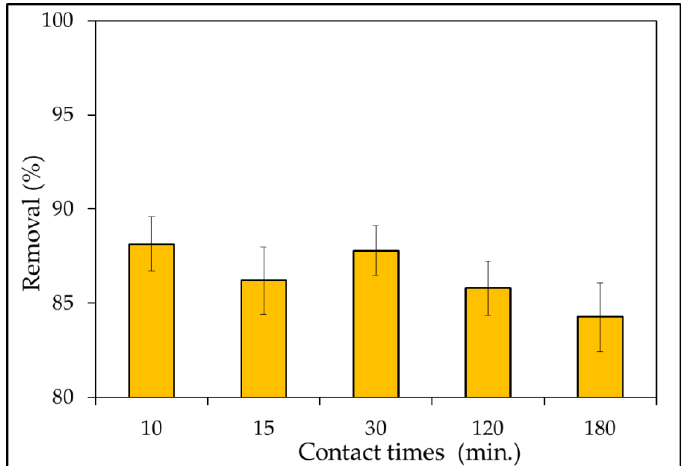
Figure 10. Effect of contact times on the removal (%) of MBD (different contact time (10 – 180); adsorbent dosage (0.1 g); MBD initial concentration 5 mg L − 1 ; pH value 10; temperatures 303 K; 180 rpm; and initial volume: 50 mL).